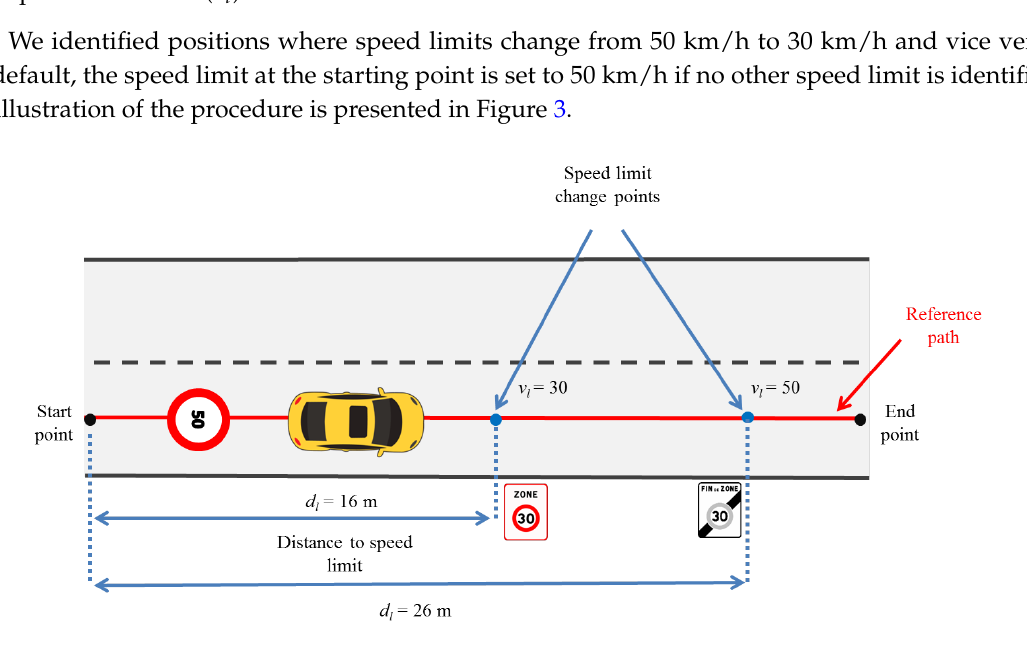
Figure 3. Speed limit driving